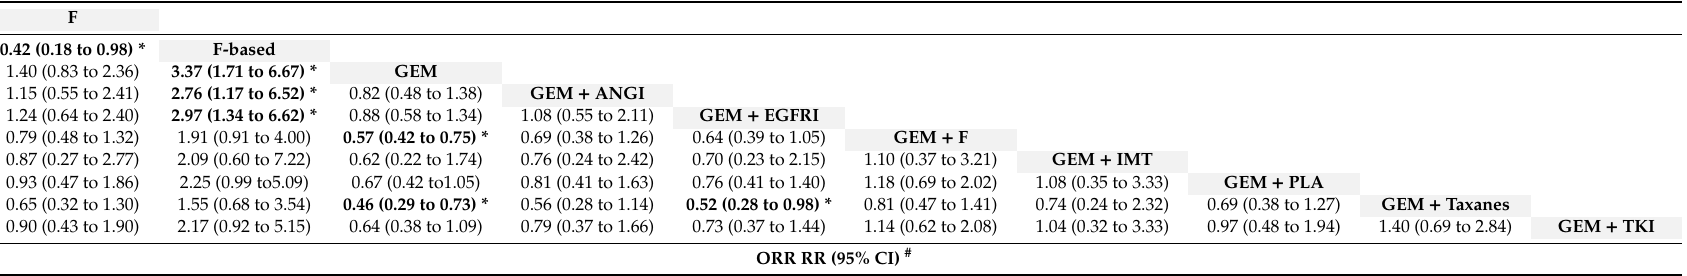
Table 2. Indirect comparison of objective response rate. Results of indirect comparison for objective response ratio were presented in the left lower half. F 0.42 (0.18 to 0.98)